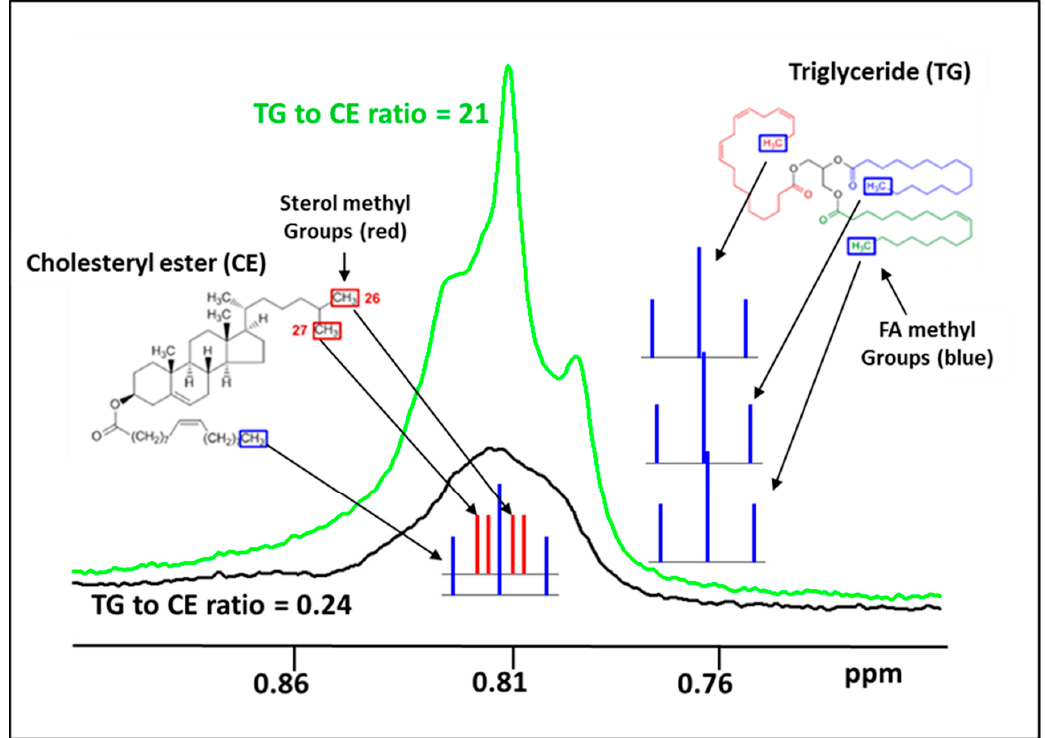
Figure 8. Illustration of the two types of methyl groups that contribute to the detected LDL signal: (1) “fatty acid (FA) methyls” (blue) at the termini of the three triglyceride (TG) fatty acyl chains and the cholesteryl ester (CE) acyl chain, and (2) the C26 and C27 “sterol methyls” (red) of the CE. In normal LDL (black line), both types of methyl groups make substantial contributions to the overall NMR signal lineshape. As the ratio of TG / CE increases in LP-Z particles, the lineshape gets sharper and taller as it is dominated by the increase in the signals from the FA methyl triplets